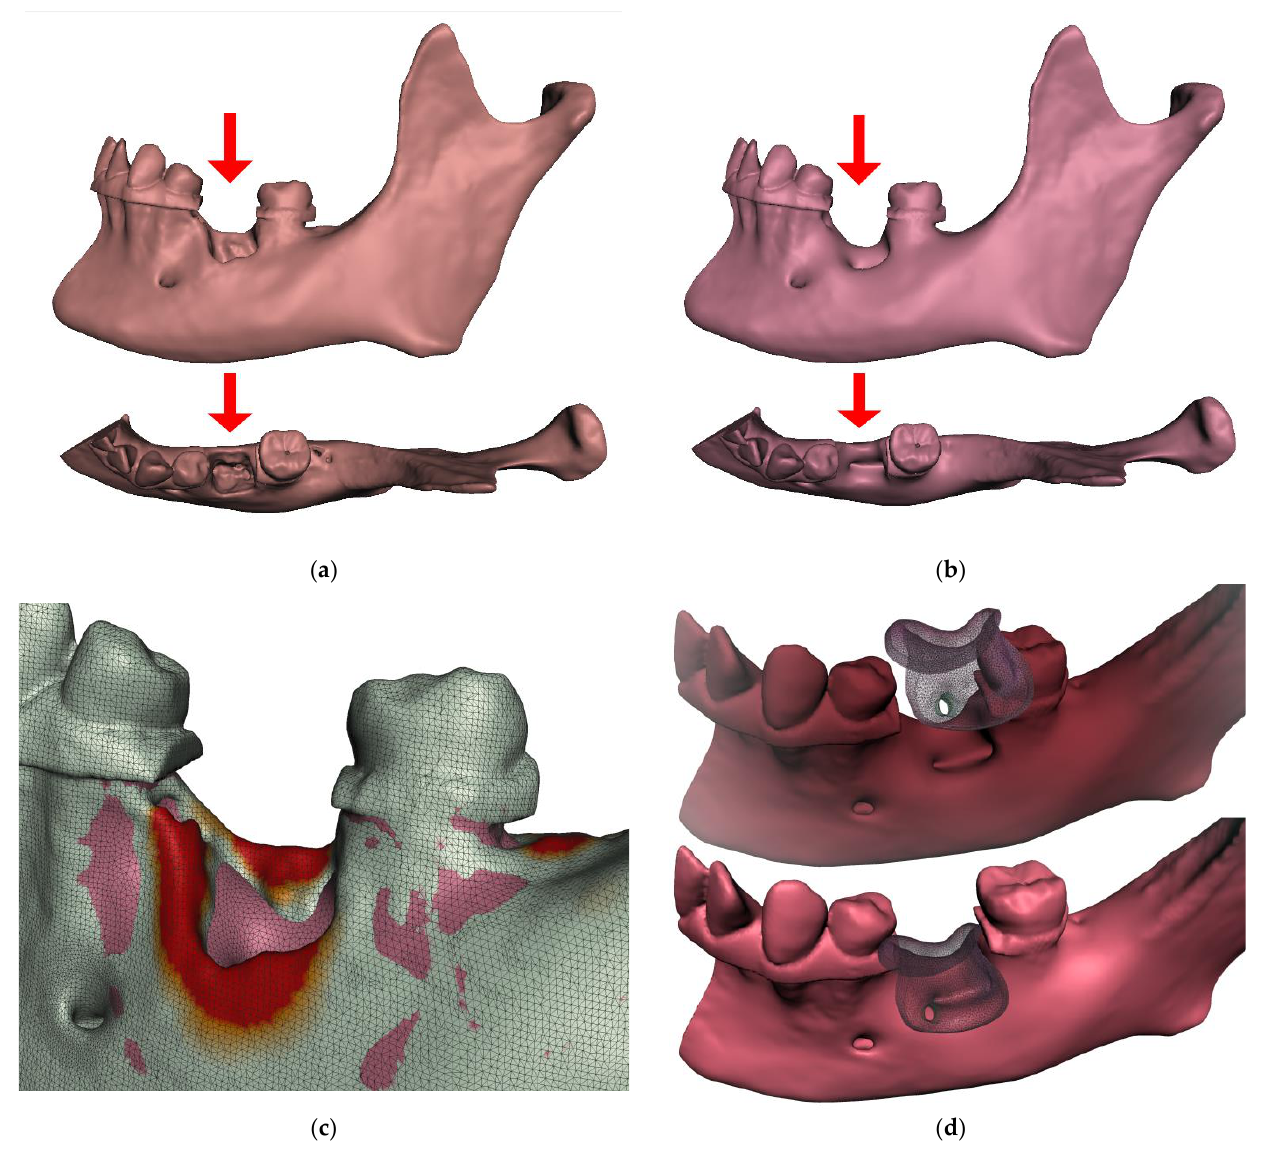
Figure 1. Following tooth extraction, the alveolar ridge undergoes an inevitable remodeling process. The concept of prospective clinical application of colonized 3D printed personalized scaffolds: ( a ) Extraction of a molar in the mandible can be the cause of an extensive loss of alveolar bone; ( b ) smoothing of the natural bone ridges and remodeling, typically leading to further recession of the alveolar bone level in this area; ( c ) a differential heat map of the comparison of aligned segmented CBCT models may reveal the extent of bone remodeling that has occurred; ( d ) a prospective scenario for the use of colonized scaffolds in clinical situations where an augmentation of alveolar bone is